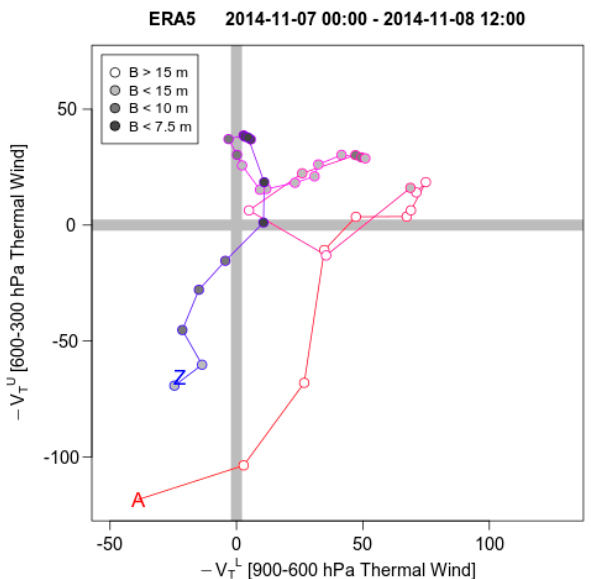
Figure 5. Phase space diagram of lower layer thermal wind (900–600 hPa, − V TL ) versus upper layer thermal wind (600–300 hPa, − V TU ). The asymmetry parameter, B, is denoted by the shade in the interior of the circles according to the legend, so that white circles correspond to a non-symmetric core and darker grey circles correspond to a more symmetric core. The color of the lines and circles changes with time from red to blue. Data are based on the ERA5 hourly dataset from 00:00 UTC, November 7, 2014 to 12:00 UTC, November 8, 2014.